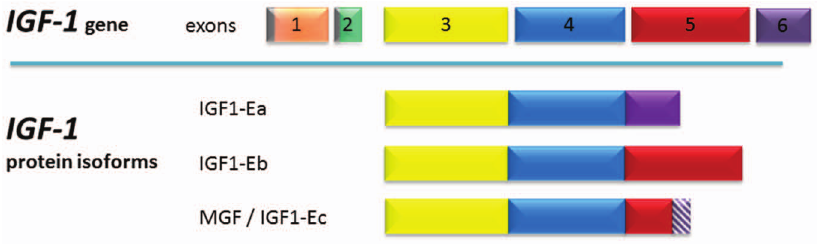
Figure 1. Genomic organization and protein structure of the porcine Igf1 . The core transcript, consisting of exons 3 and 4 (yellow and blue), is either spliced to exon 1 (orange) or exon 2 (green). IGF1-Ea is joined to exon 6 (violet). IGF1-Eb is joined to exon 5 (red). Mgf consists of the exons 3, 4, the N-terminal part of exon 5, consisting of 49 or 52 nucleotides (depending on the species) and exon 6 (striated violet). Exon 5 evokes a frame shift in exon 6 resulting in an altered amino acid sequence at the C-terminal end. The two dark grey regions symbolize the promoter regions of the corresponding transcript. The colours of the exons were chosen to match a corresponding figure of the human IGF gene in Goldspink G Physiology 2005;20:232–238.